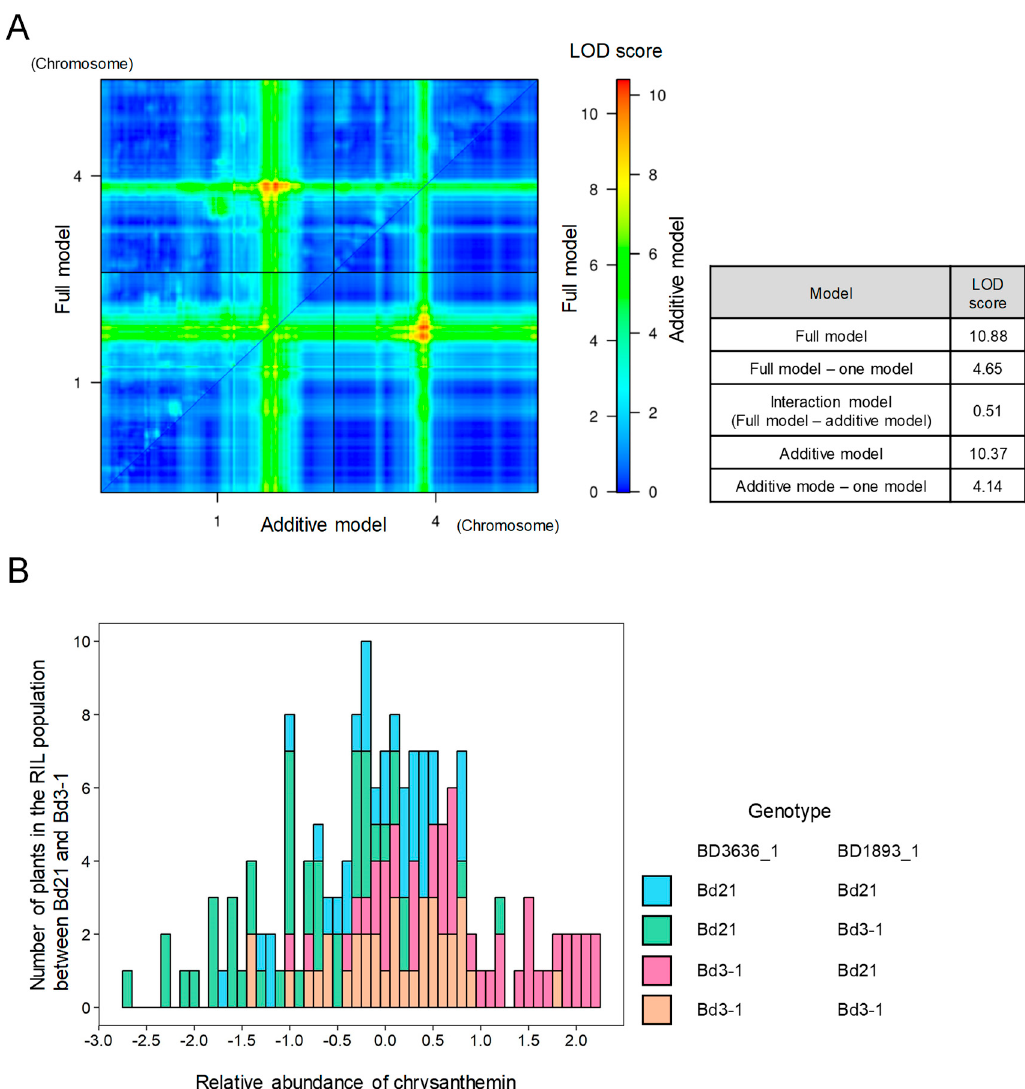
Figure 5. Interaction of QTLs in the accumulation of chrysanthemin in the Bd3-1 × Bd21 RILs. ( A ) LOD scores corresponding to additive or full (additive and interaction) models for each combination of chromosomes 1 and 4 QTLs for the accumulation of chrysanthemin. The upper left and lower right triangles represent the results of the full and additive models, respectively. The color scale indicates separate LOD score scales for the full and additive models. LOD scores computed using five models are represented on the two-dimensional QTL scan. ( B ) Combined effects of the two QTLs on the accumulation of chrysanthemin in the RILs. The histogram represents the phenotypic distribution of chrysanthemin accumulation in the RILs for the four genotype combinations corresponding to the two SNP markers Bd3534_1 and BD1893_1, located on chromosomes 1 and 4, with the maximum LOD score.